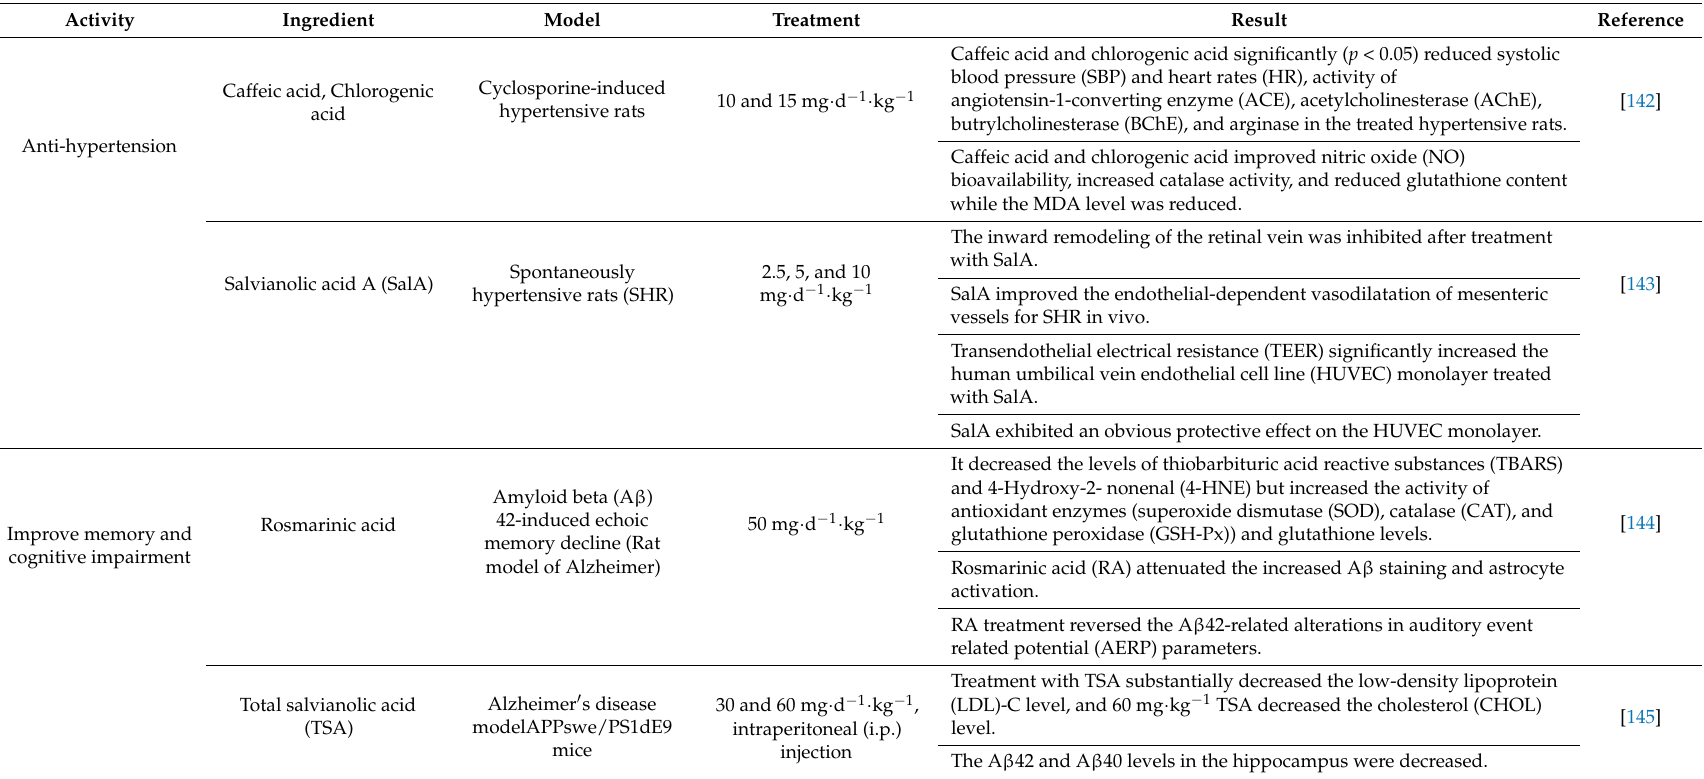
Table 3. Other activities of phenolic acids in Salvia